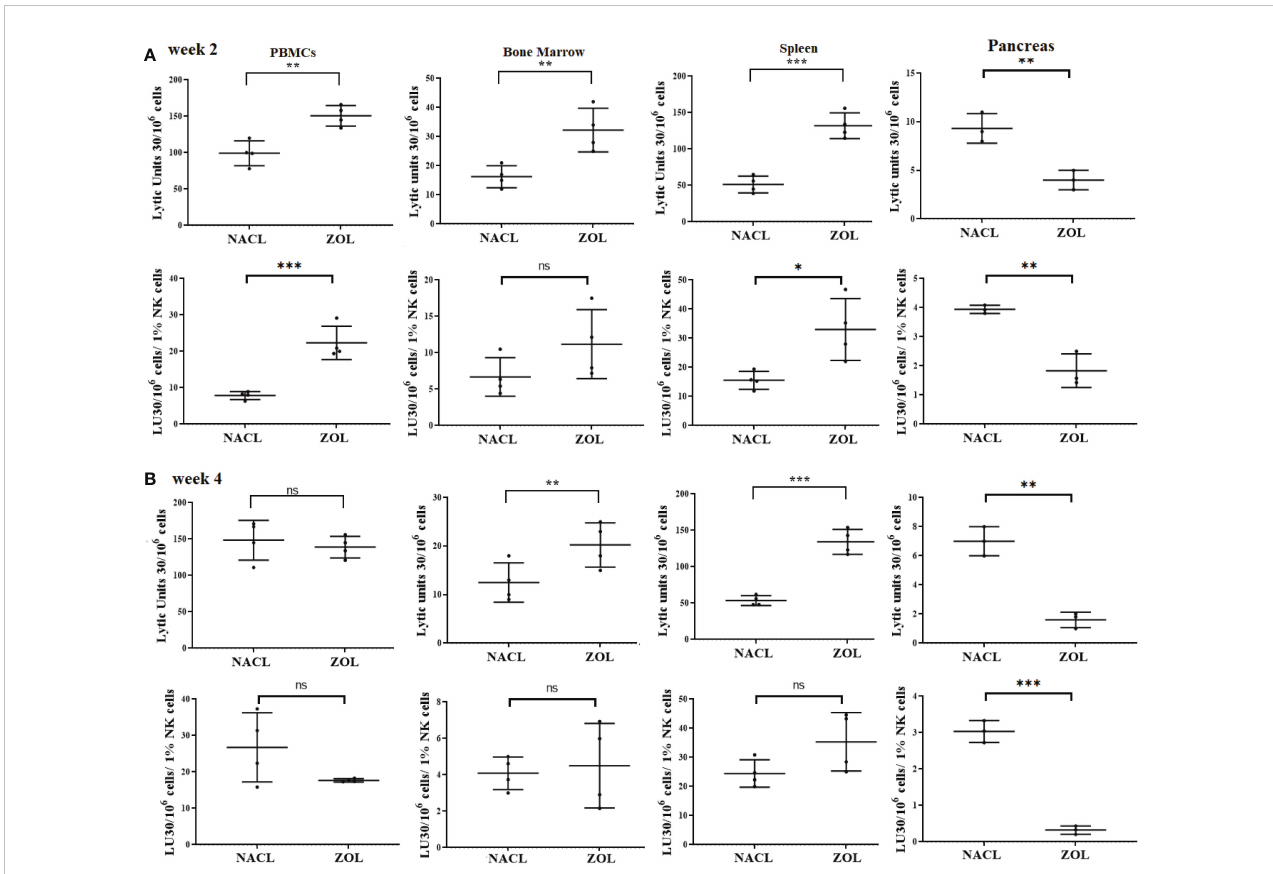
FIGURE 5 NK cell-mediated cytotoxicity in PBMCs, BM, spleen and pancreas of NACL or ZOL-injected and tooth-extracted hu-BLT mice. Hu-BLT mice were administered with either 0.9% NACL or ZOL (500 µg/kg) via IV followed by maxillary left fi rst molar extraction as described in Materials and Methods section. Two (A) or four weeks (B) after tooth extraction, mice were euthanized and tissues were harvested to obtain single cell suspension. PBMCs (n=4), BM (n=4), splenocytes (n=4), and pancreas (n=3) of hu-BLT mice were cultured (2 × 10 6 cells/2ml) with IL-2 (1000 U/ml) for three days, after which the cells were used as effector cells in standard 4-hour 51 Cr release assay against human OSCSCs tumors. Lytic units (LU) 30/10 6 cells were determined using inverse number of effector cells required to lyse 30% of OSCSCs × 100. LUs per 1% NK cell were determined using CD16+CD56+ percentages obtained by fl ow cytometric analysis (A, B) . ***(p value<0.001), **(p value 0.001-0.01), *(p value 0.01-0.05) , ns (no signi fi